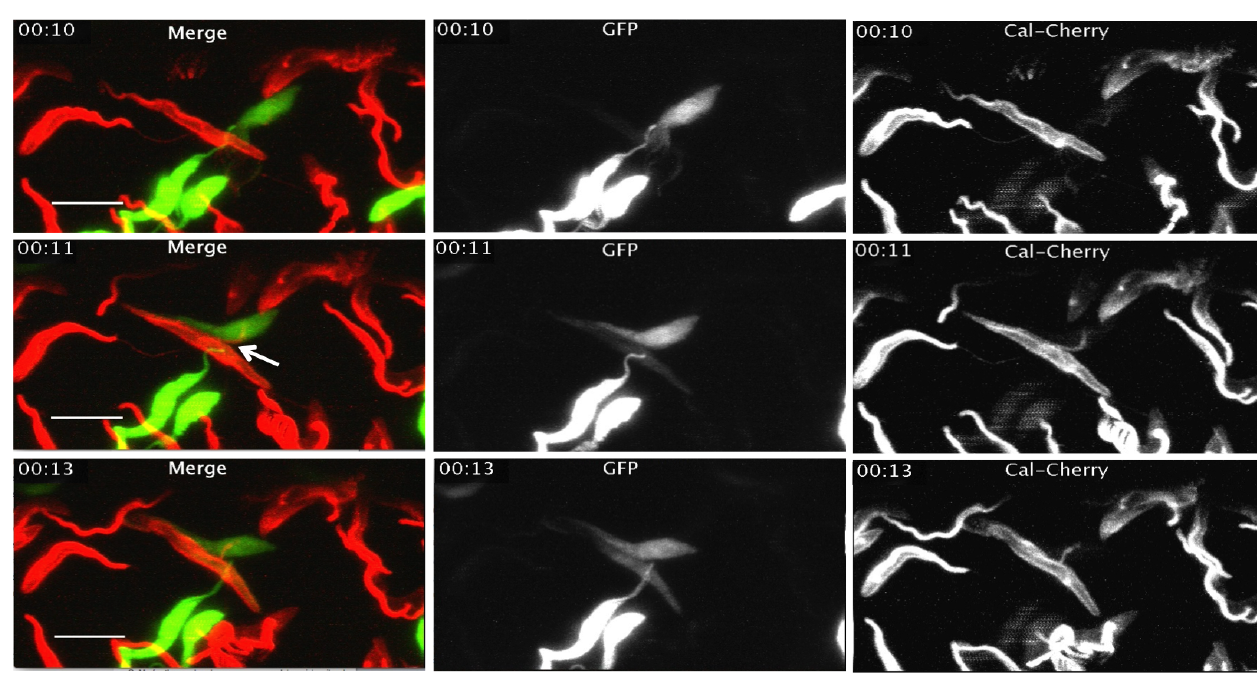
Figure 6. Time-lapse microscopy shows a rapid exchange of cytoplasmic and flagellar proteins. Still images from lattice light sheet fluorescence microscopy time-lapse video (Video 3) of trypanosomes expressing either GFP ( Δ proc) or calflagin44-mCherry (WT). The time interval is indicated at the left upper corner of the image. The scale bar is 10μm. First image (00:10): cells are only positive for one fluorescent protein. Second image one minute later (00:11), calflagin44-mCherry is present on both cells, but GFP is detected only weakly in the second cell. Third image: two minutes later (00:13), GFP is equally distributed in both interacting